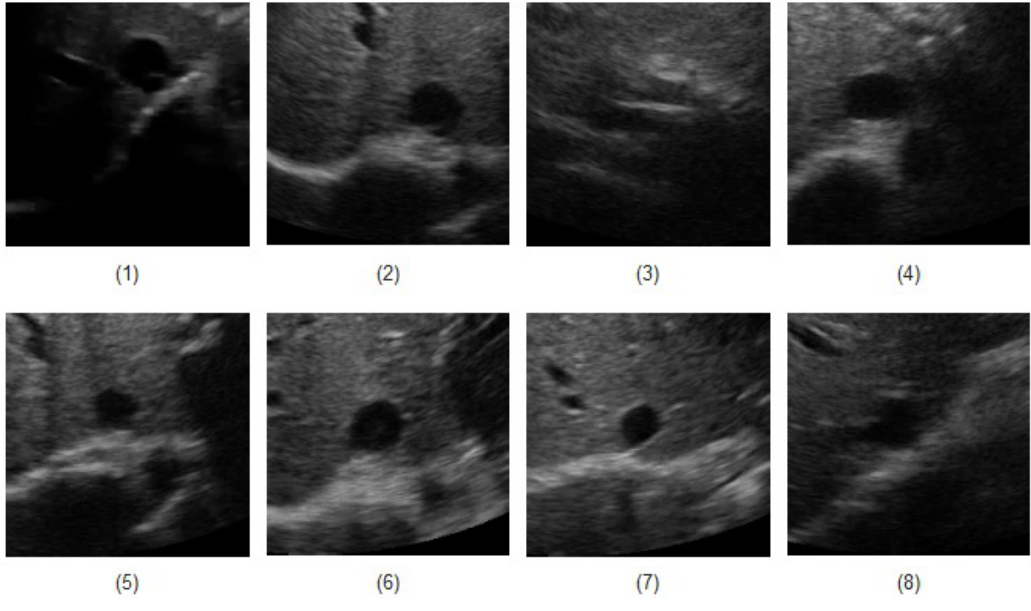
Figure 5. The first frame of all eight IVC